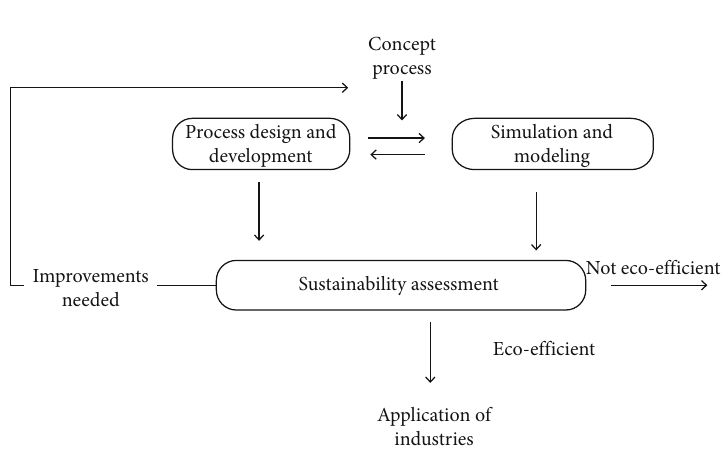
Figure 2: Decision in the Process Development.